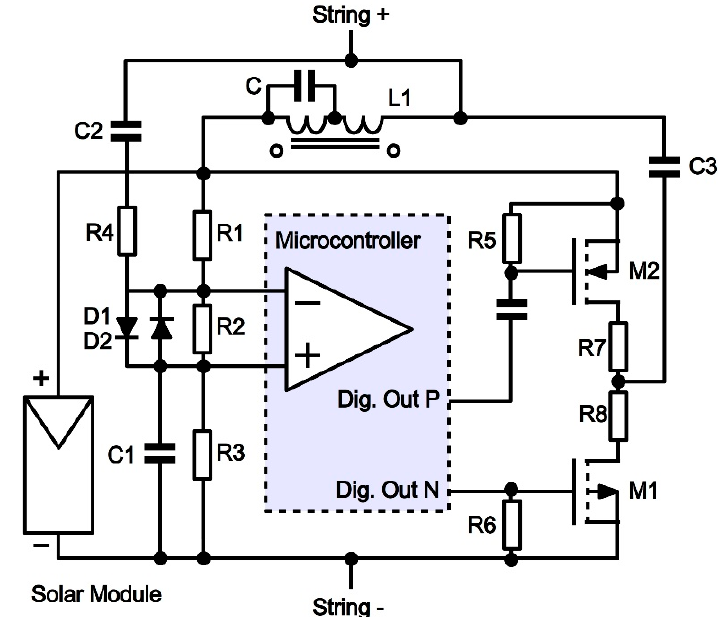
Figure 1. PLC circuitry for transmission and